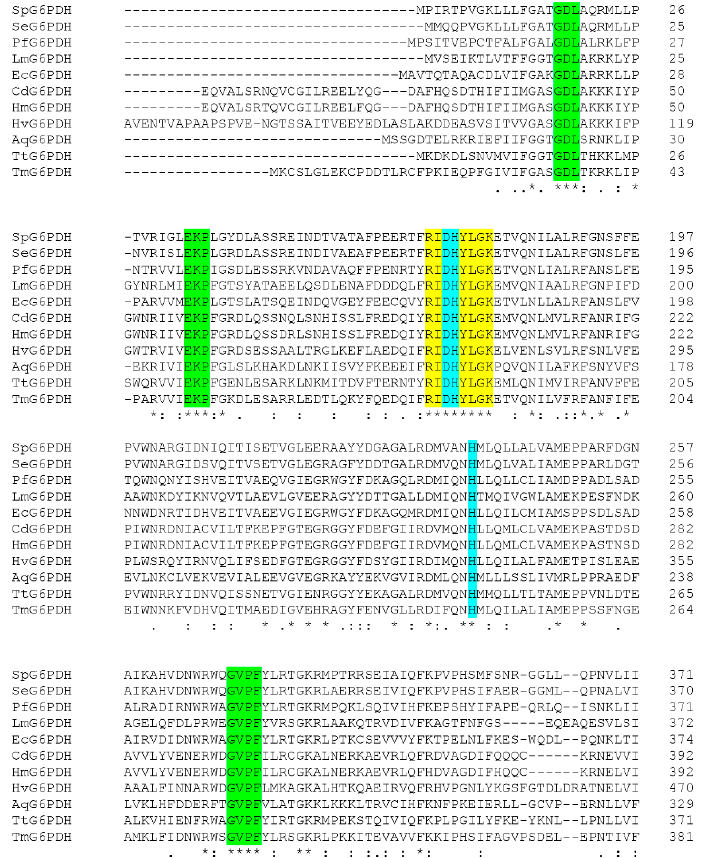
Figure 1. Multiple alignments of glucose 6-phosphate dehydrogenase (G6PD) sequences. SpG6PD1 ( Sphingomonas sp. PAMC 26621), SeG6PD ( Sphingomonas elodea [20]), PfG6PD ( Pseudomonas fluorescens [21]), LmG6PD ( Leuconostoc mesenteroides [5]), HmG6PD (Human [22]), EcG6PD ( Escherichia coli [23]), CdG6PD ( Camelus dromedarius [24]), HvG6PD ( Hordeum vulgare [25]),